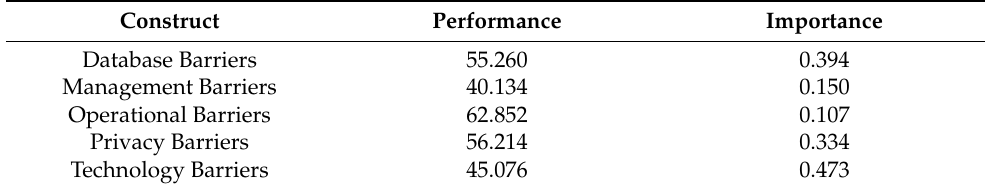
Table 11. IMPA constructs